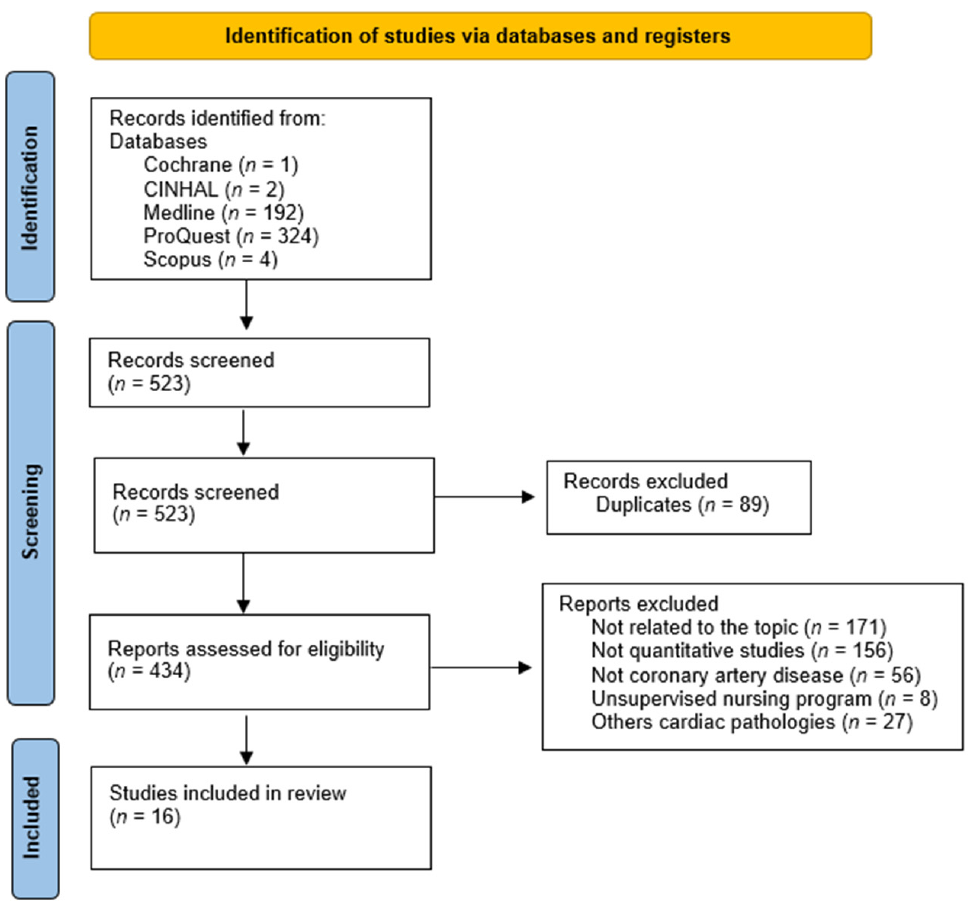
Figure 1. Flow diagram of the publication search process.